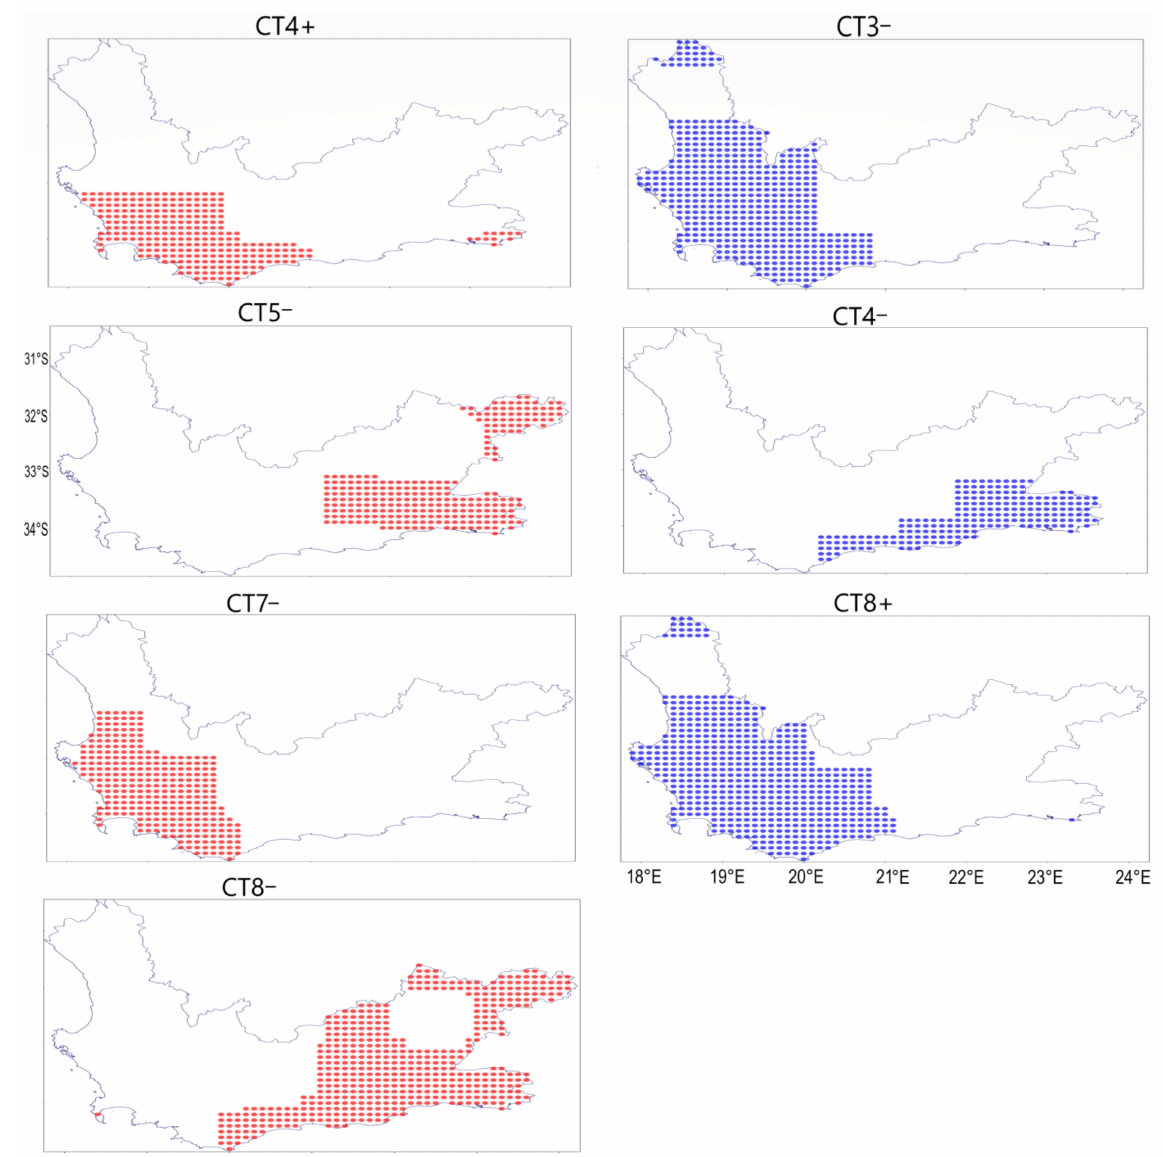
Figure 6. Rainfall anomaly associated with wet CTs (right panel) and the dry CTs (left panel). The anomaly was calculated as the difference between the season when the CTs are dominant and the climatology of the season. Blue (red) dots indicate grid points with statistically significant positive (negative) rainfall